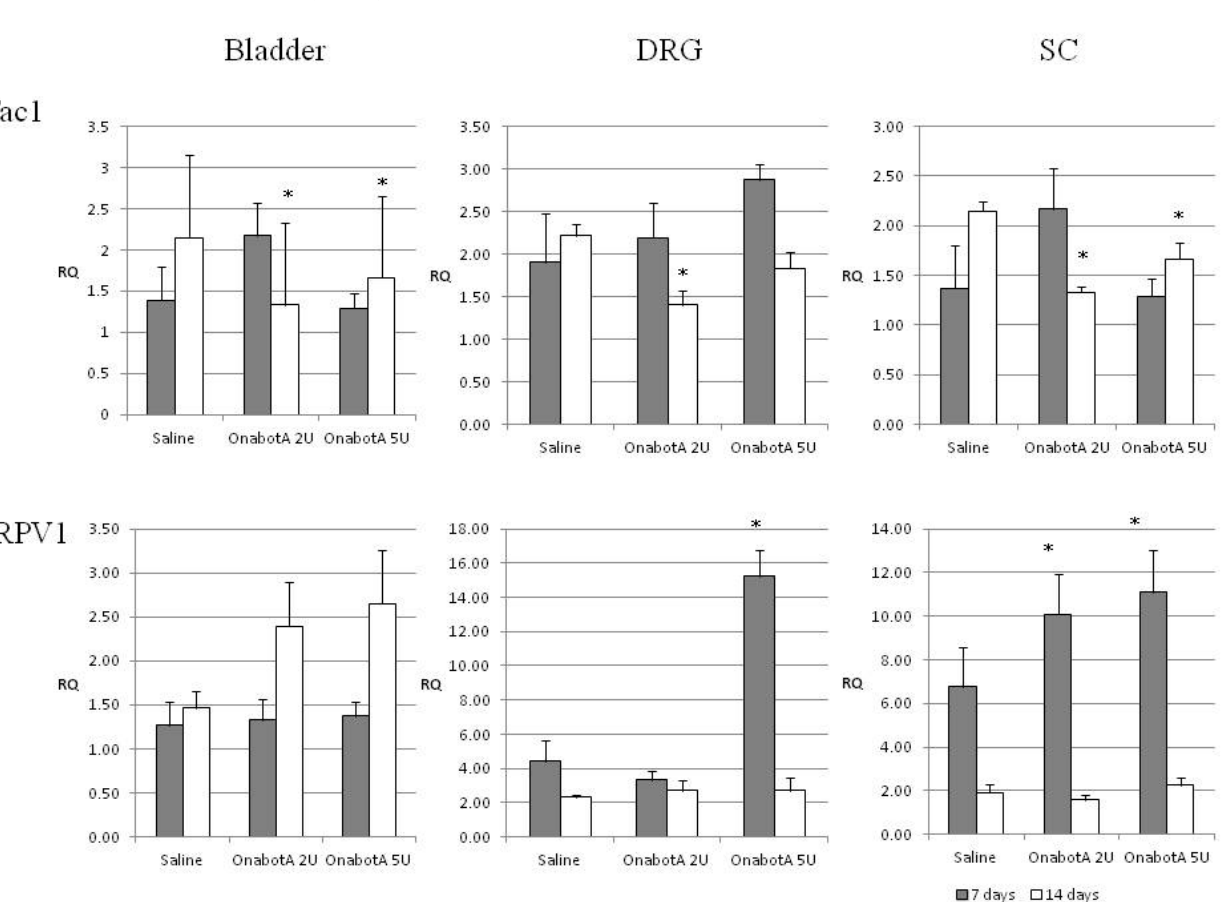
Figure 1. Relative expression of sensory markers Tac1 and TRPV1 in the bladder, DRG (dorsal root ganglia) and SC (spinal cord) of saline-treated (7 days post-treatment, n = 5; and 14 days post- treatment, n = 5) and OnabotulinumtoxinA-treated rats (7 days post-treatment, n = 5; and 14 days post-treatment, n = 5). Expression was normalized to that of GAPDH. RQ: relative quantification. Error bar: standard deviation. *: statistically significant difference ( p < 0.05) with respect to saline.